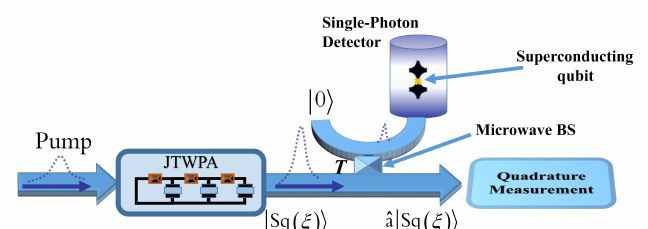
Figure 1. Schematics for generating approximate traveling cat states in circuit-quantum electrodynamics (QED). After the Josephson traveling-wave parametric amplifier (JTWPA), a squeezed vacuum state | Sq ( ξ ) (cid:105) is propagating in a transmission line. A microwave beam splitter (BS) with transmission T is located between two transmission lines. Once a microwave photon is detected using a superconducting qubit inside a cavity, the state becomes a single-photon subtracted SVS in the other line approximately. This can be verified by quadrature